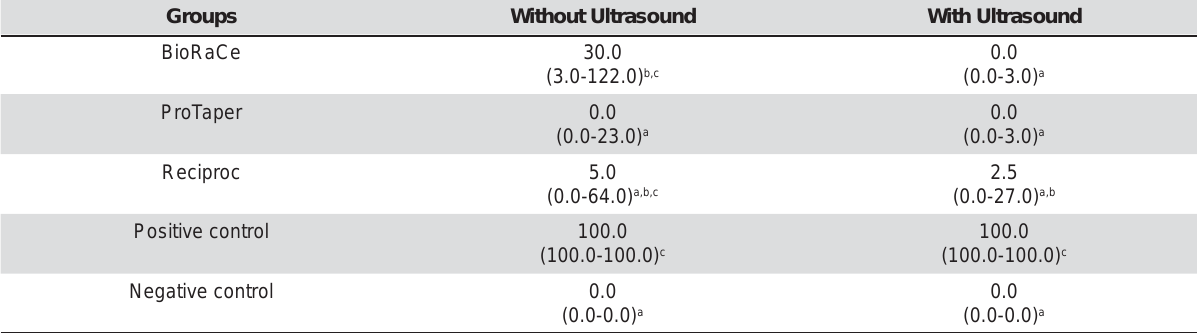
a,b,c - Different letters indicate statistical differences among the